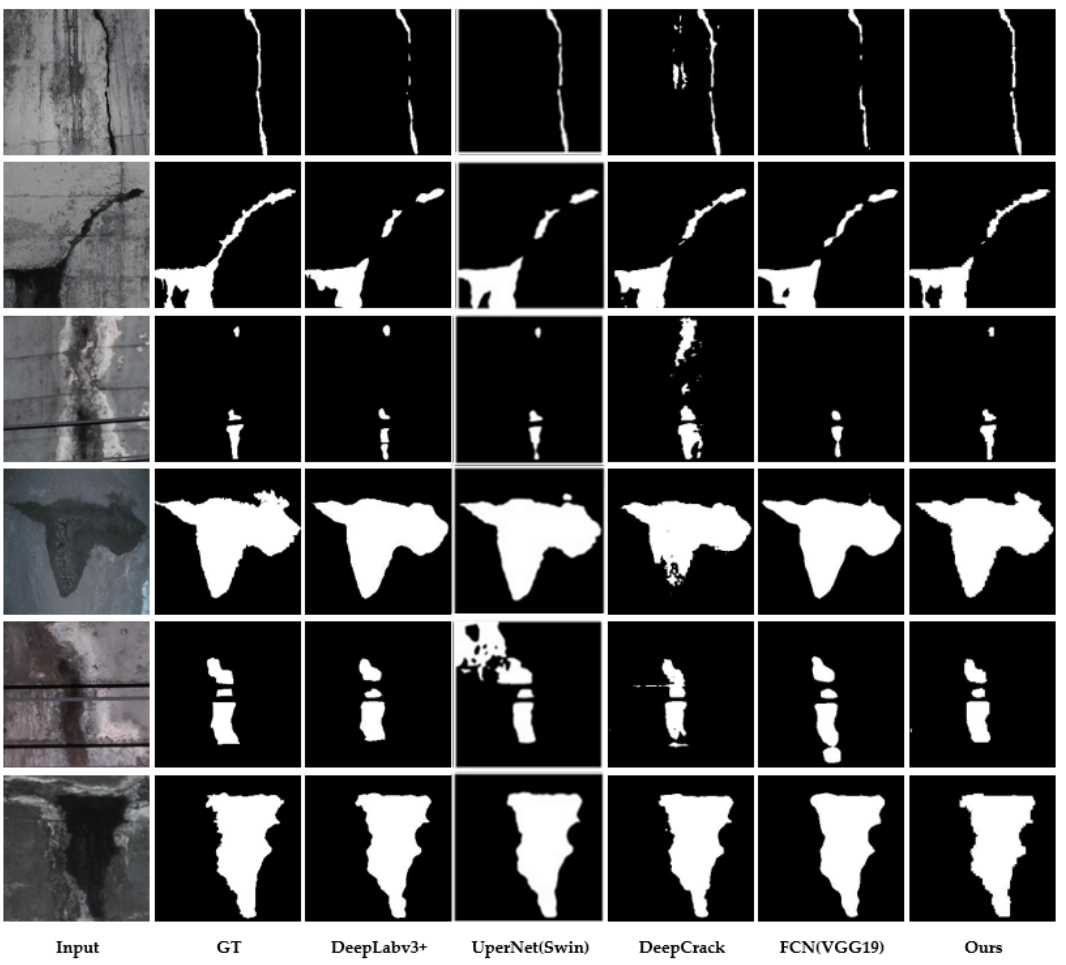
Figure 10. Visualization of the inference results obtained by different state-of-the-art deep learning models on our tunnel leakage test